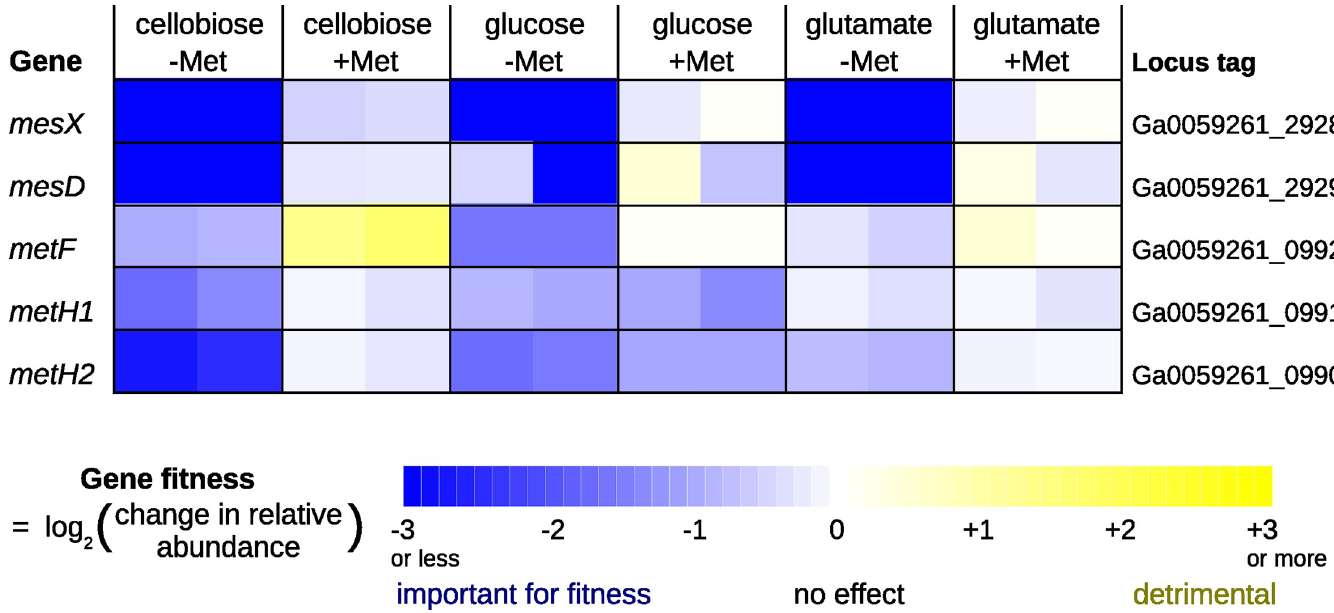
Fig 5. Sphingomonas koreensis can grow in minimal media by using MesD and not MetF. A pool of transposon mutants was grown in a defined minimal media with a single carbon source and without added vitamins. Some cultures were supplemented with 250 μ M L-methionine. Each cell in the heatmap shows a gene fitness value from a different experiment; each condition has two replicates. A gene fitness value is the log 2 change in the relative abundance of mutants in that gene during that experiment (from inoculation at OD 600 = 0.02 until